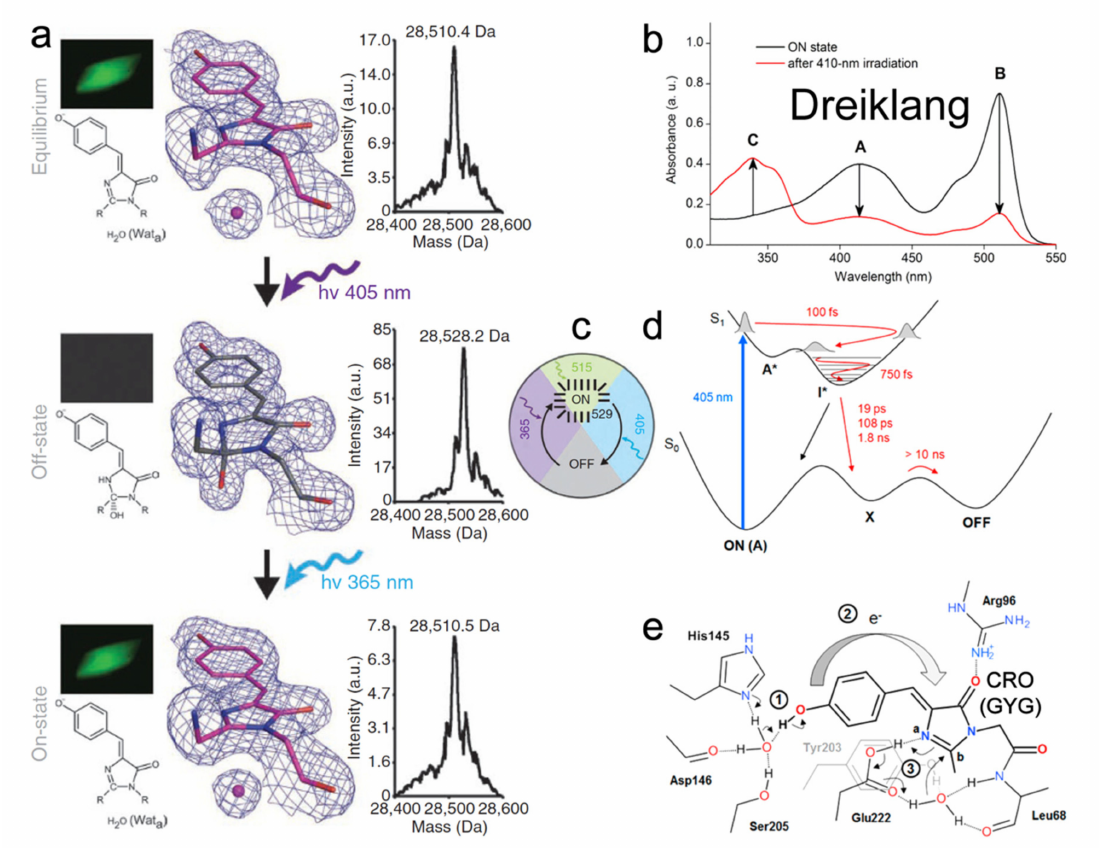
Figure 10. Photophysical characterization of the Dreiklang photoswitching. ( a ) Representative protein crystals with proposed chemical structures of the associated chromophores. Middle panels from top to bottom: X-ray structures with PDB IDs of 3ST2, 3ST3, 3ST4 [23]. For the equilibrium and on states, an I-ring-adjacent water molecule (Wat a , purple sphere) is separately shown. Right panels: representative ESI-MS spectra of Dreiklang photoswitched in solution, the mass change due to one water addition in the off state is conspicuous. ( b ) Steady-state absorption spectra of the on-(black) and off-state (red) of Dreiklang in aqueous buffer solution at pH 7.5. ( c ) Switching modality scheme for Dreiklang. ( d ) Schematic excited-state (S 1 ) and ground-state (S 0 ) potential energy surfaces during the on-to-off photoswitching with intermediates and associated time constants. X likely represents an anionic chromophore-water adduct state. ( e ) On-state chromophore H-bonding network with key surrounding residues, with arrows 1–3 depicting the proposed hydration event after electronic excitation. Adapted with permission from Ref. [23]. Copyright 2011 Nature America, Inc. Adapted with permission from Ref. [92]. Copyright 2017 American Chemical